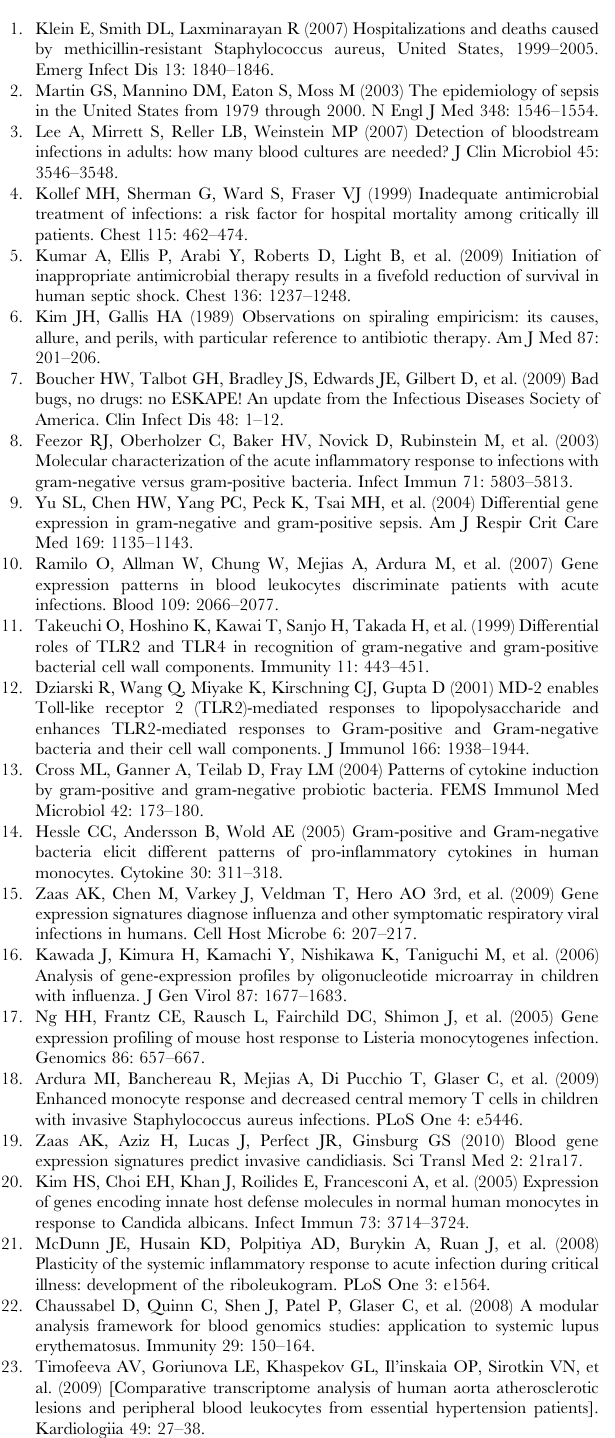
Table S5 Genes in pathways common to murine and human responses to infection. Human genes are in the shaded cells. Murine genes are in the unshaded